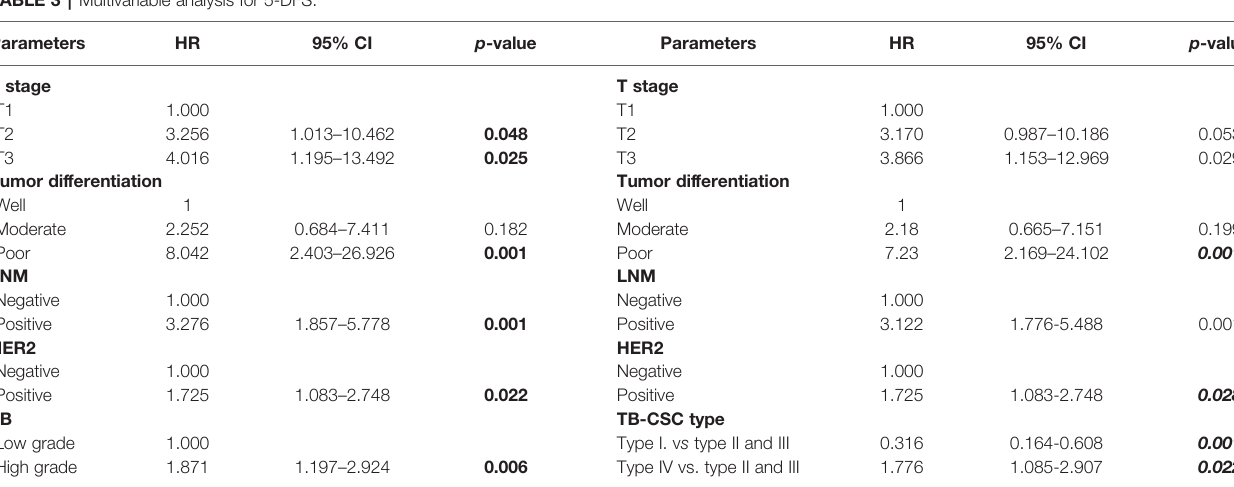
TABLE 3 | Multivariable analysis for